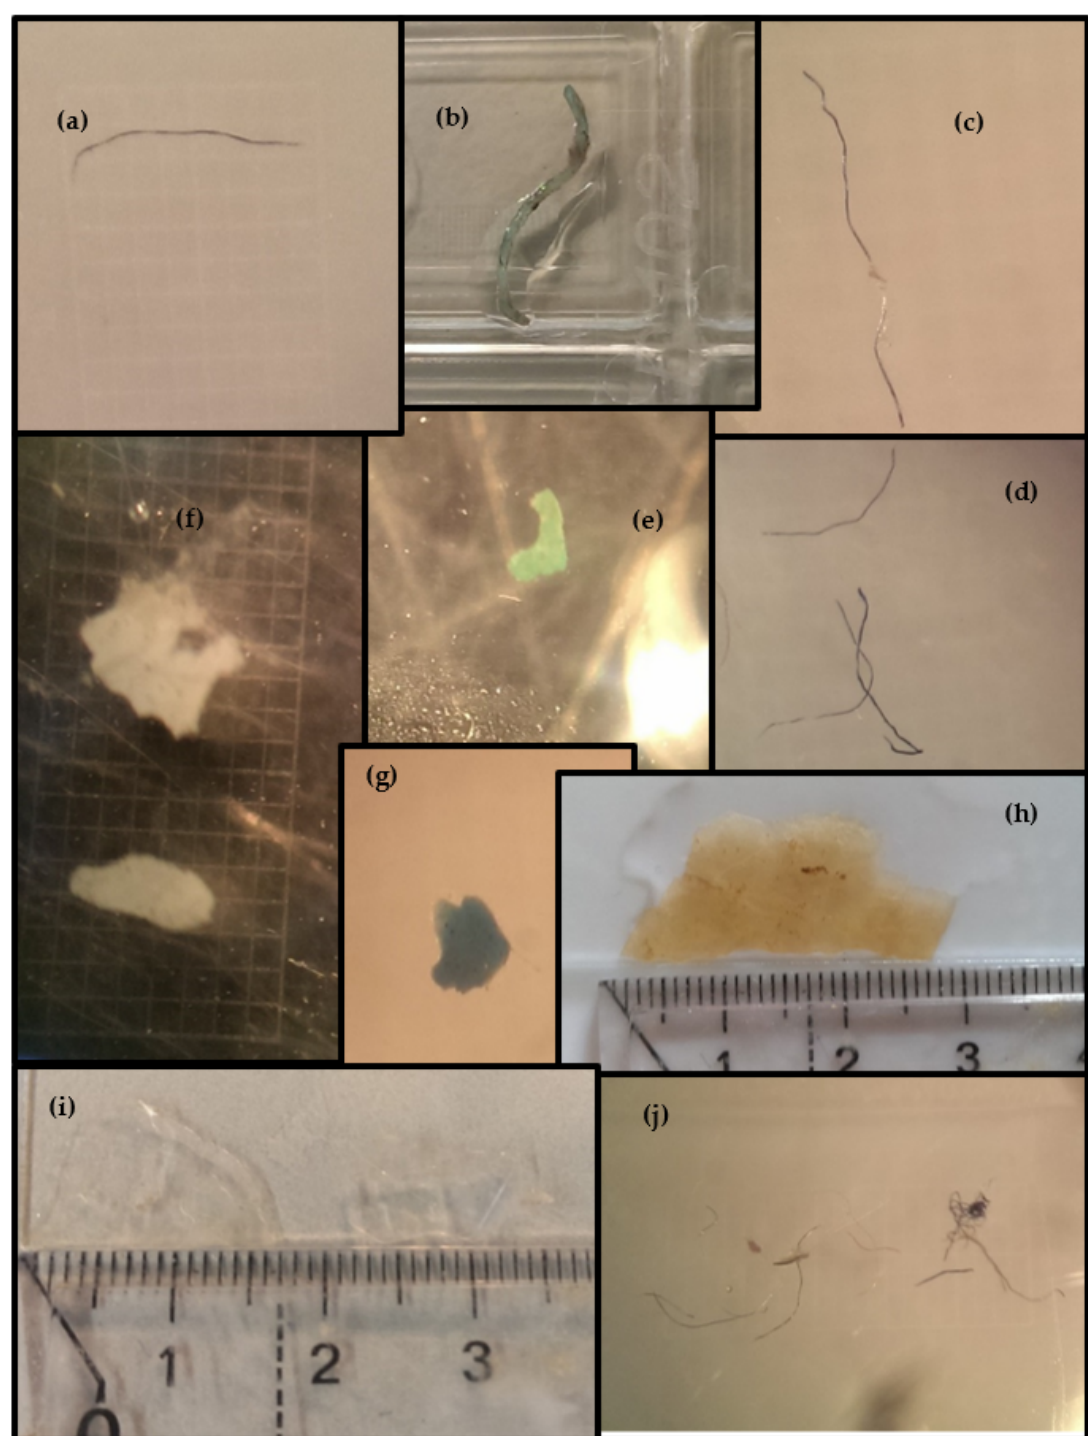
Figure 2. Images of microplastics particles found in the stomach contents of two opportunistic deep–water predators Coelorinchus caelorhinchus and Galeus melastomus from the bathyal plane of the Central Thyrrhenian Sea. Filaments ( a – d ) are distinguished by having both lengths much higher than height and thickness detectable by a needle pit. Fragments ( e – h ) are irregularly shaped with different height and length and distinct thickness. Laminas ( i ) are smoothly shaped with different height and length and negligible thickness. Fibres and filaments compared ( j ), on the left and right side of the image, respectively.